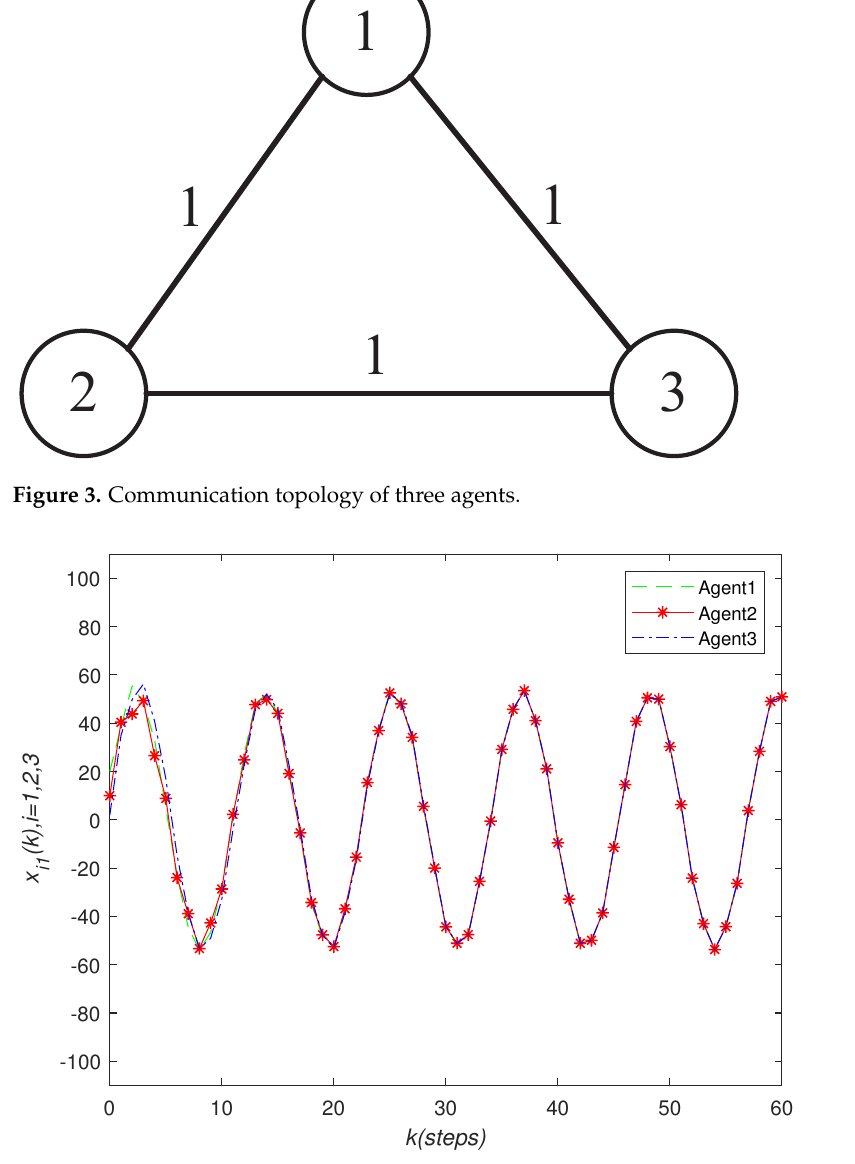
Figure 4. State trajectories x i 1 ( k ) of agent i